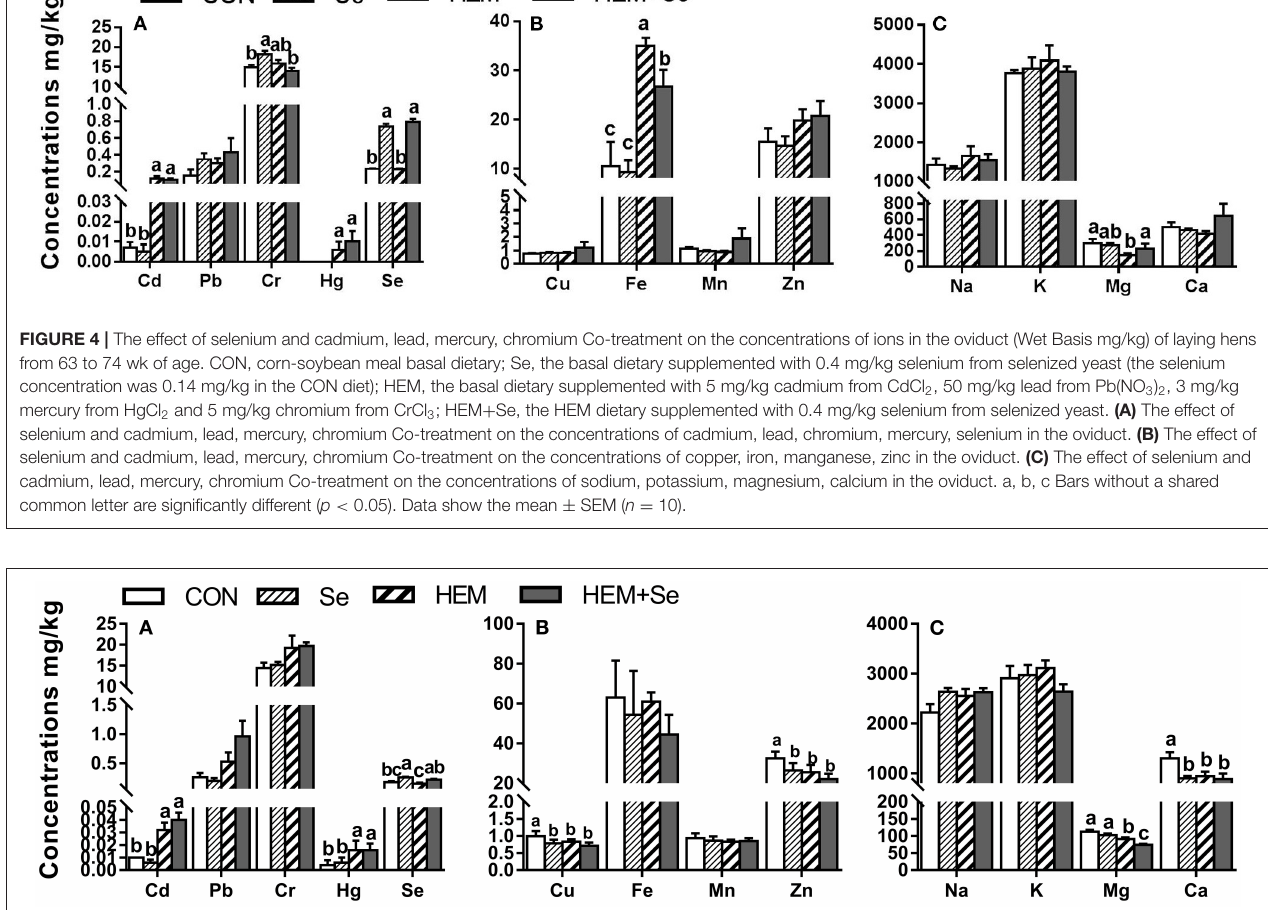
FIGURE 5 | The effect of selenium and cadmium, lead, mercury, chromium Co-treatment on the concentrations of ions in the follicular walls (Wet Basis mg/kg) of laying hens from 63 to 74 wk of age. CON, corn-soybean meal basal dietary; Se, the basal dietary supplemented with 0.4 mg/kg selenium from selenized yeast (the selenium concentration was 0.14 mg/kg in the CON diet); HEM, the basal dietary supplemented with 5 mg/kg cadmium from CdCl 2 , 50 mg/kg lead from Pb(NO 3 ) 2 , 3 mg/kg mercury from HgCl 2 and 5 mg/kg chromium from CrCl 3 ; HEM + Se, the HEM dietary supplemented with 0.4 mg/kg selenium from selenized yeast. (A) The effect of selenium and cadmium, lead, mercury, chromium Co-treatment on the concentrations of cadmium, lead, chromium, mercury, selenium in the follicular walls. (B) The effect of selenium and cadmium, lead, mercury, chromium Co-treatment on the concentrations of copper, iron, manganese, zinc in the follicular walls. (C) The effect of selenium and cadmium, lead, mercury, chromium Co-treatment on the concentrations of sodium, potassium, magnesium, calcium in the follicular walls. a,b,c Bars without a shared common letter are significantly different ( p < 0.05). Data show the mean ± SEM ( n = 10).